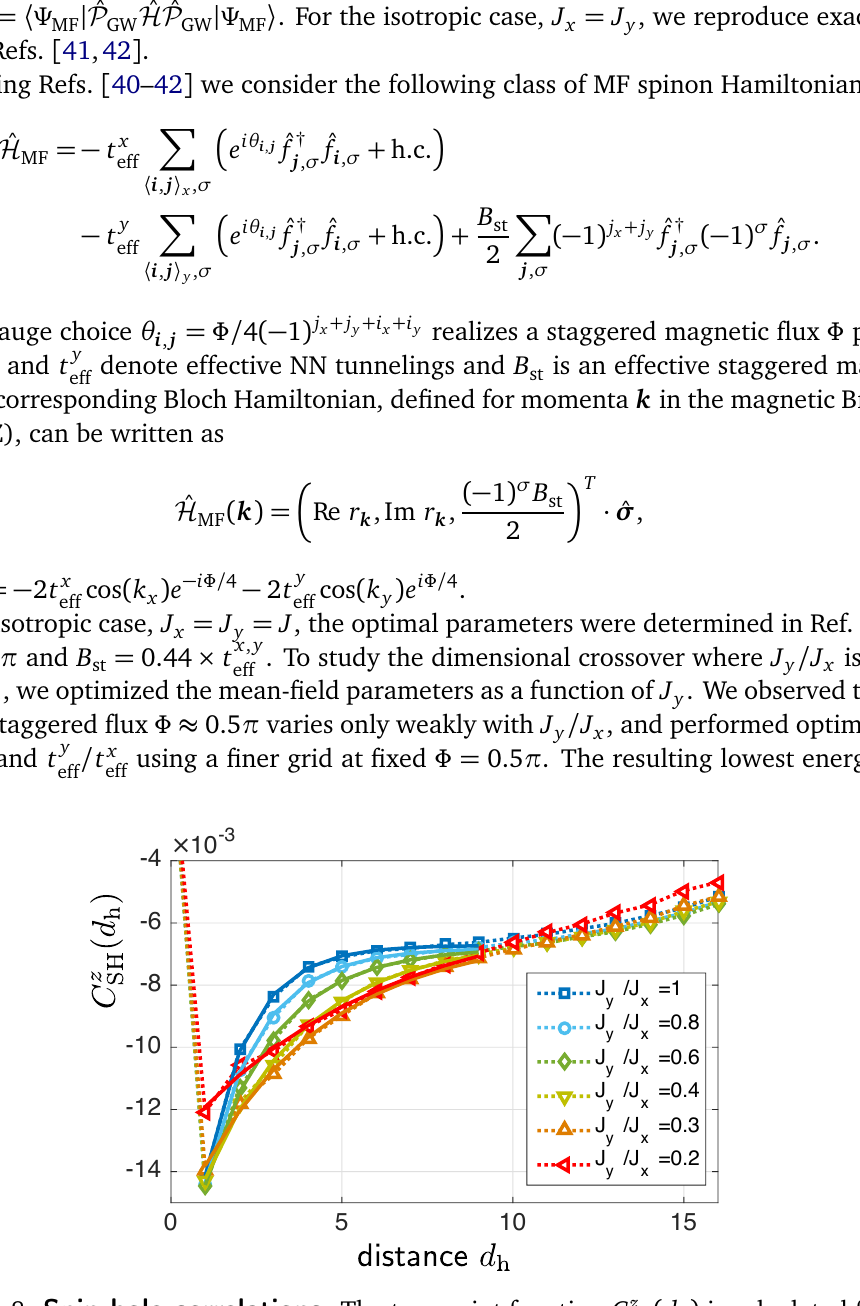
Figure 8: Spin-hole correlations. The two-point function C z different values of J using DMRG. Parameters are L y t = 3 J . The solid lines indicate fits of the form A x ) extract the length scale ξ ( J y